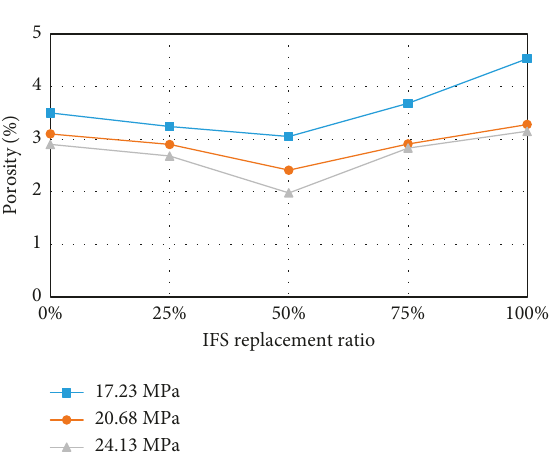
Figure 10: Porosity with respect to different IFS replacement ratio.